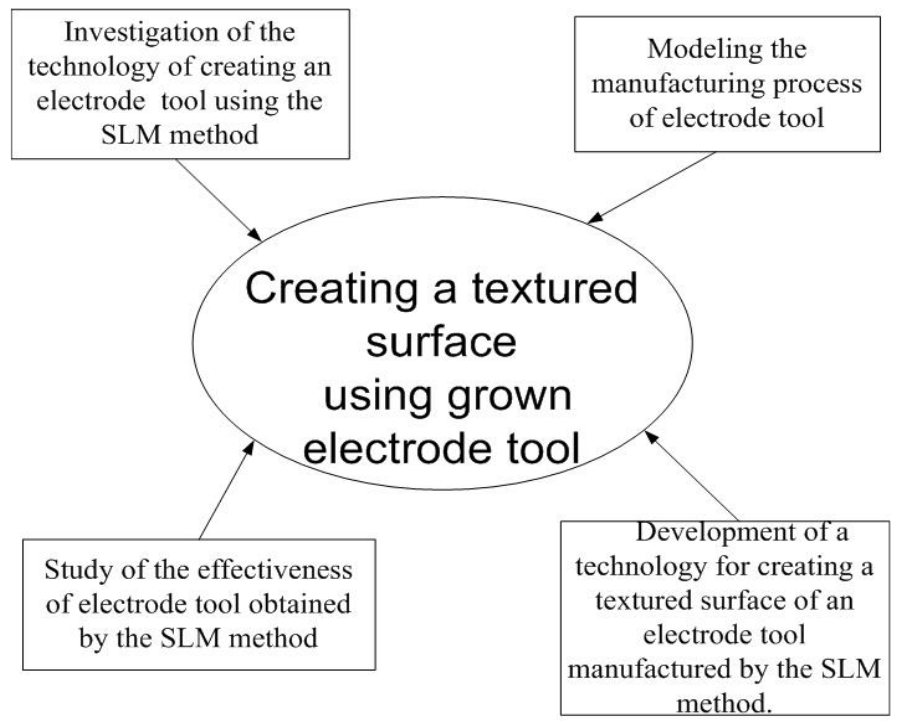
Figure 2. Stages of creating a textured surface using the grown ET.